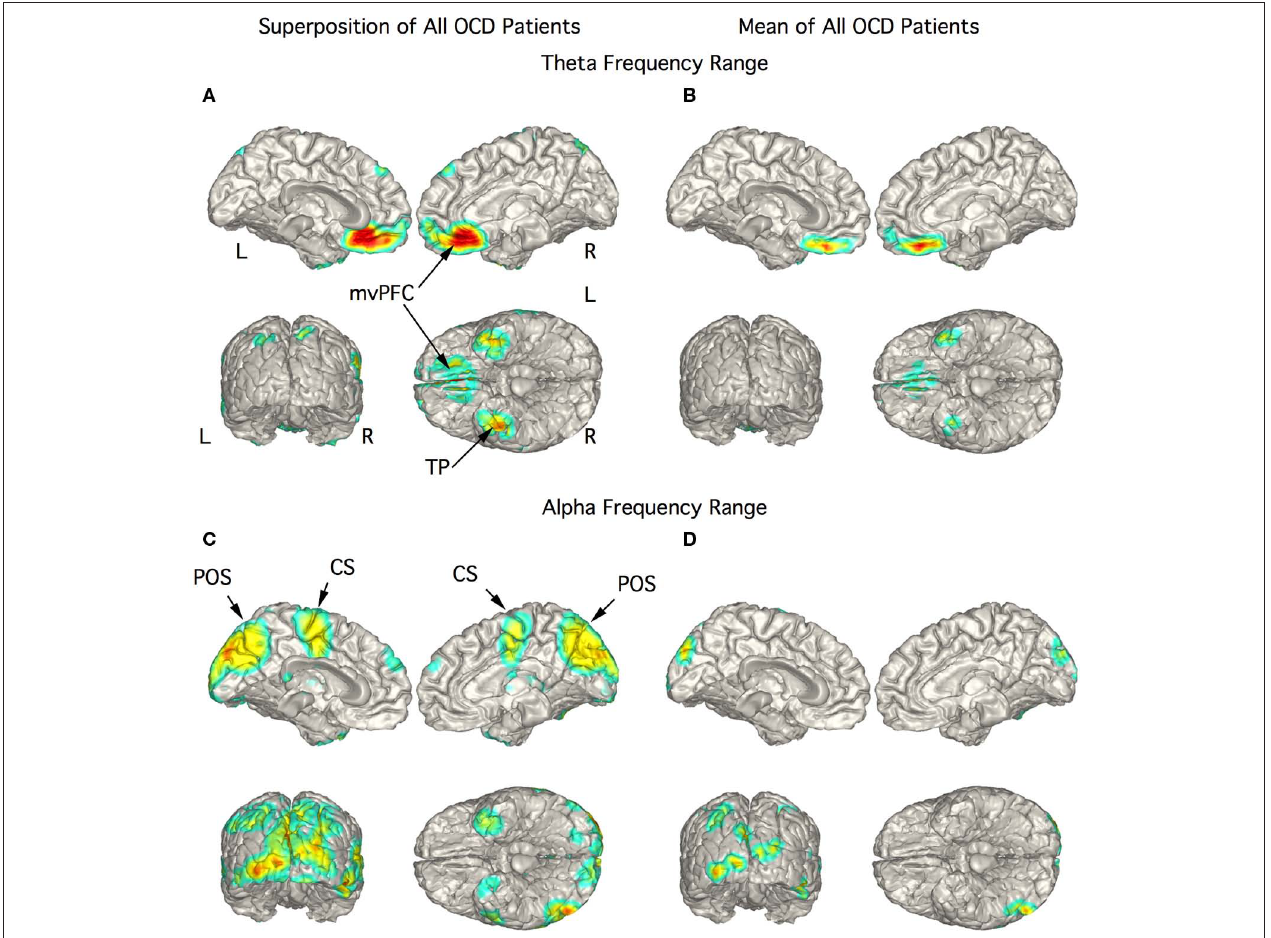
Superposition of alpha ICs that were widespread in this group of patients. (D) Mean of localizations shown in (C) reflecting the distributed nature of the localization in this chort. Abbreviations: CS, central sulcus; L, left; mvPFC, medial ventral pre-frontal cortex; POS, parieto-occipital sulcus; R, right; TP,